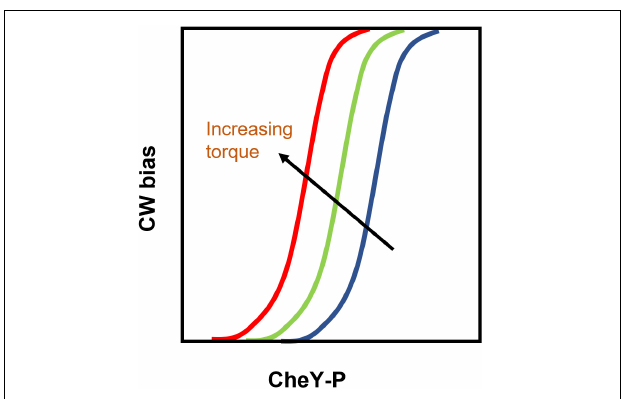
FIGURE 4 | Tuning of the CW bias –CheY-P relationship by torque: Cartoon representation of the analysis of experimental results (Antani et al., 2021a). Increasing torque shifts the CW bias versus [CheY-P] curve leftward (from the position indicated by the blue curve to the one indicated by the red curve) by modulating the affinity of FliM/FliN for CheY-P. As a result, the CW bias increases with increasing torque even though CheY-P levels remain constant. Thus, the shifting curves compensate for the inhibitory effects of increased viscous load on the motor and help maintain a load-independent CW bias (shown in Figure 3B